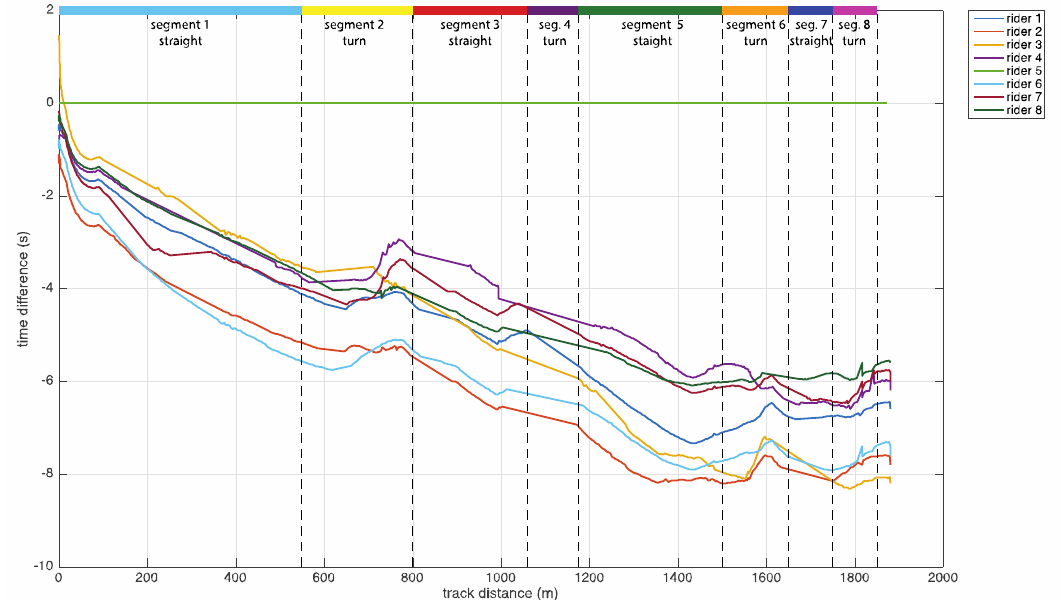
Figure 3. The time difference between each rider, for his fastest trial, as function of the travelled track distance. The trial of rider 5 is taken as the baseline to calculate the time differences between the riders. The track distance is divided into six segments. Segment 2, 4 and 6 are sharp corners.